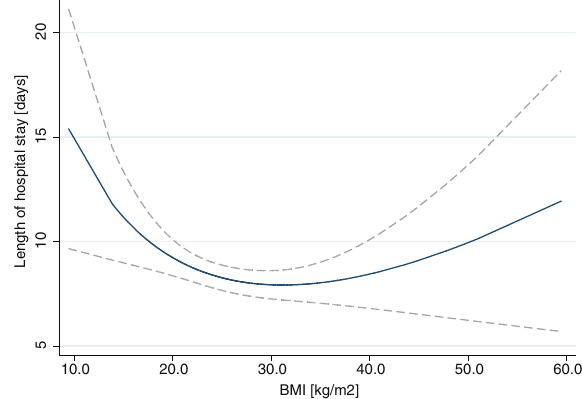
Fig. 2 BMI and length of hospital stay. Fractional polynomial estimation of the association of BMI with the length of hospital stay (LOS) (blue curve) along with the con fi dence interval of the mean (gray area). There is a U-shaped association between LOS and